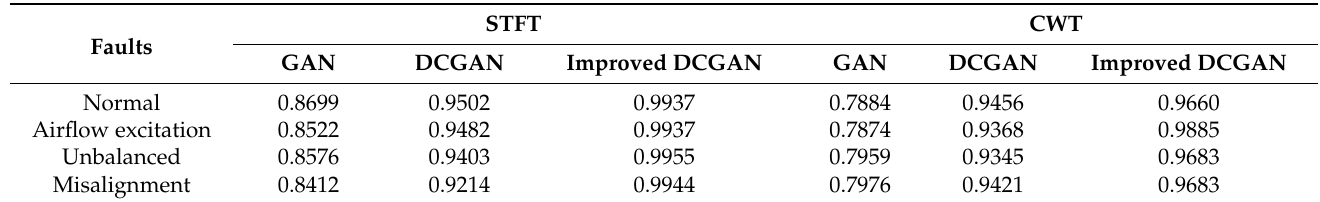
Table 4. SSIM comparisons on between generated signals and real signals under different